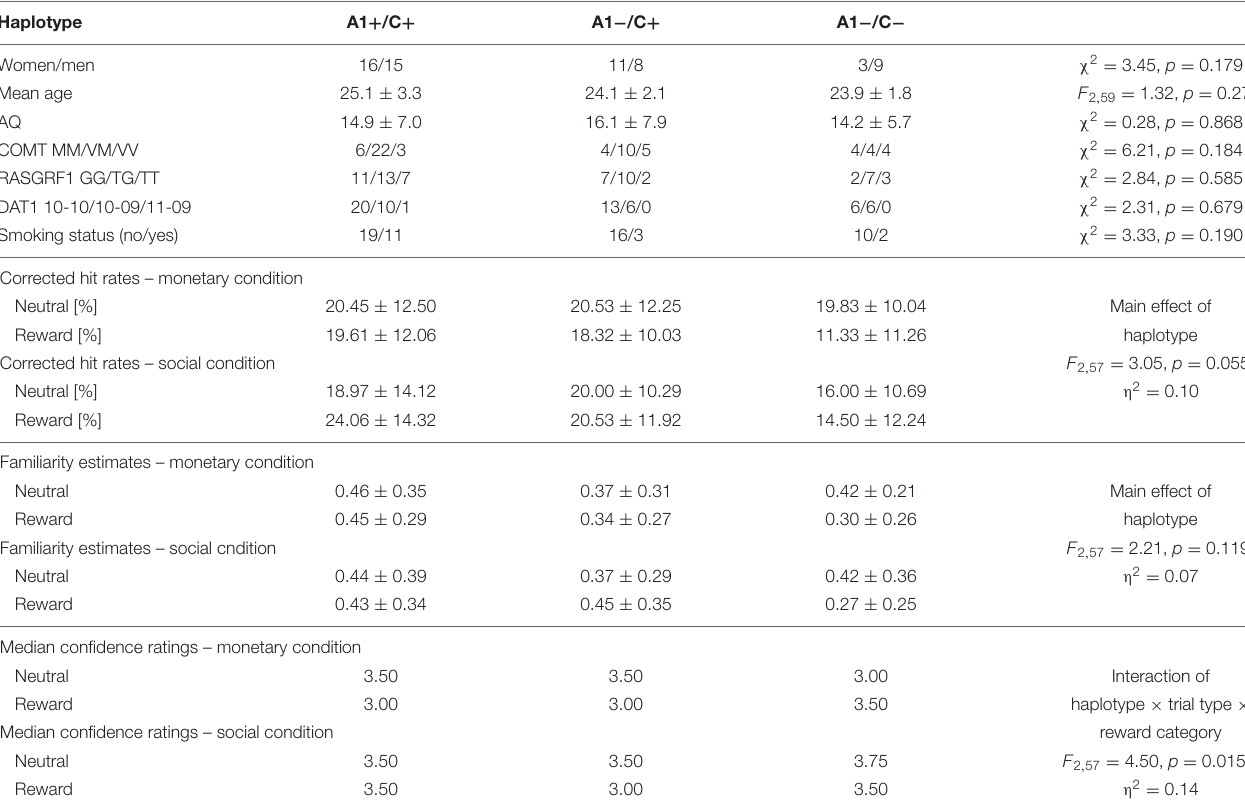
TABLE 3 | Demographic data and behavioral data of the memory parameters regarding the TaqIA/C957T haplotype.